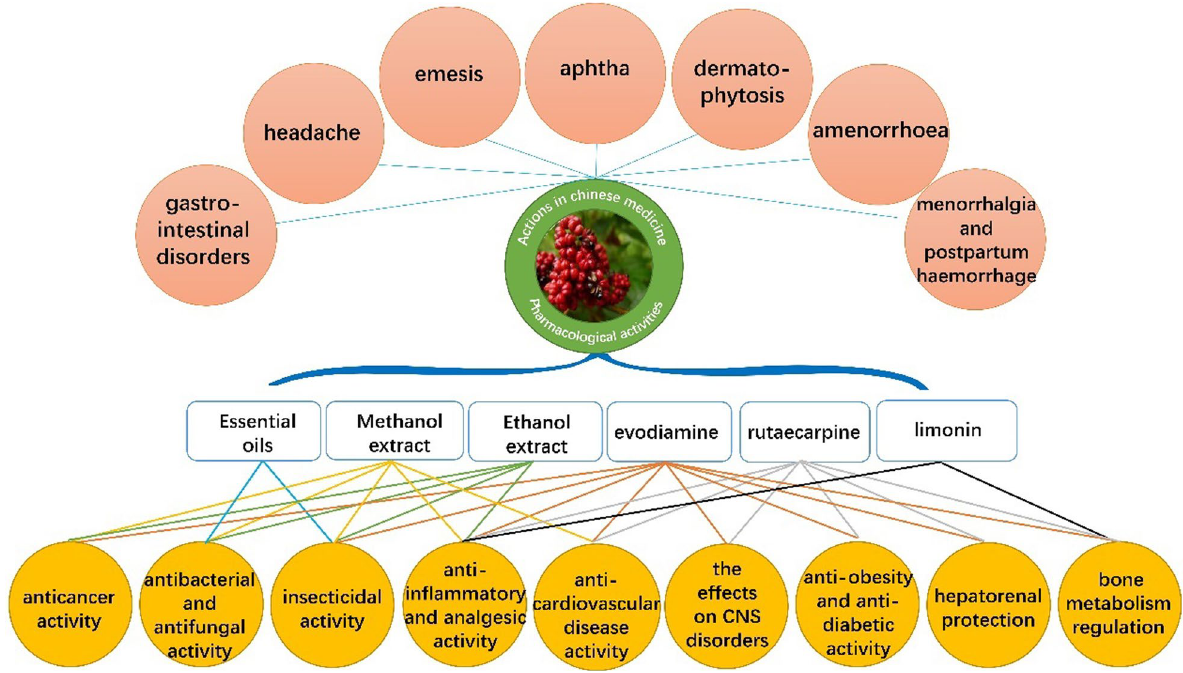
Fig. 1 Multiple pharmacological effects of Euodiae